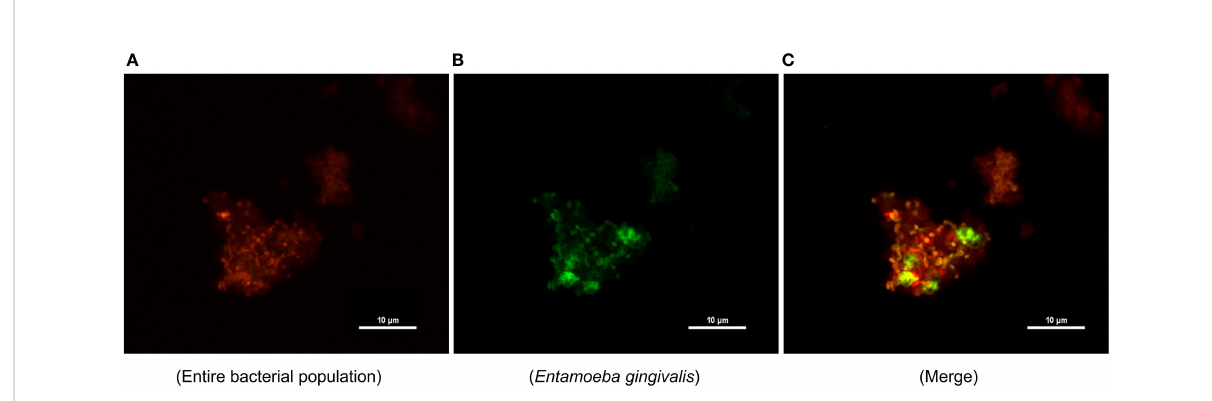
FIGURE 5 Distribution of Entamoeba gingivalis ( E. gingivalis ) in subgingival plaque detected by fl uorescence in situ hybridization. (A) The entire bacterial population is shown in red. (B) E. gingivalis is shown in green. (C) Merging of E. gingivalis and the entire bacterial population. Scale bar: 10 m m.